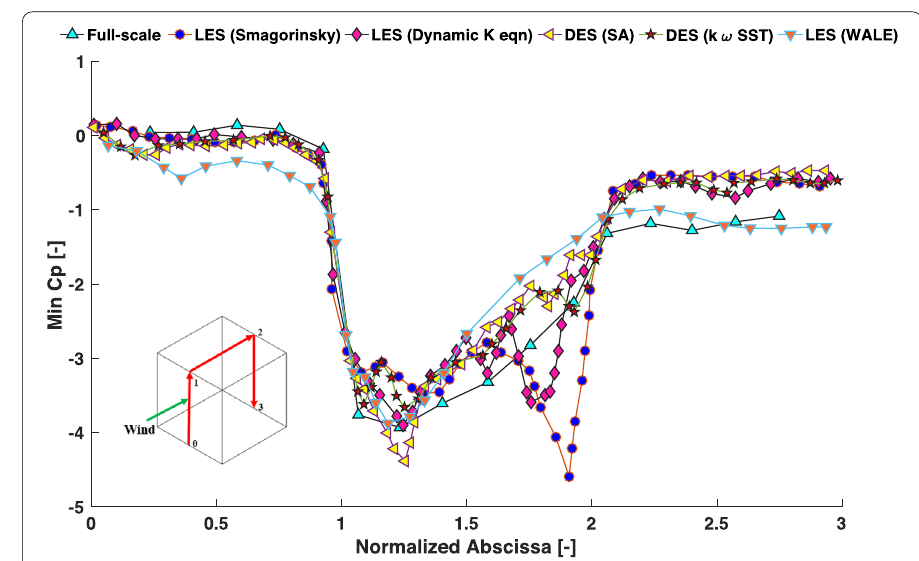
Fig. 5 Comparison of minimum (peak) surface pressure coefficients obtained using LES and hybrid simulations from the literature with full-scale